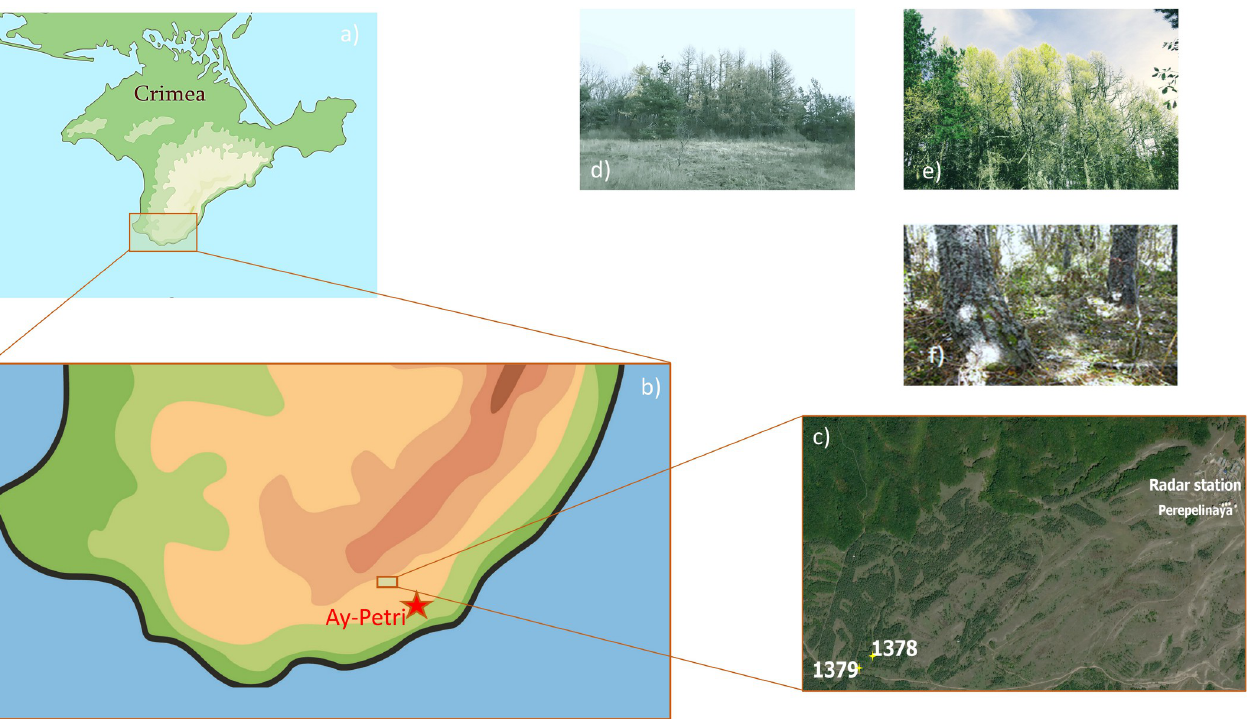
Fig 1. Soil sampling map and photos of the objects. Soil sampling point–a-c); photos of the sampling sites: meadow (d), larch (e), and canopy under a larch forest